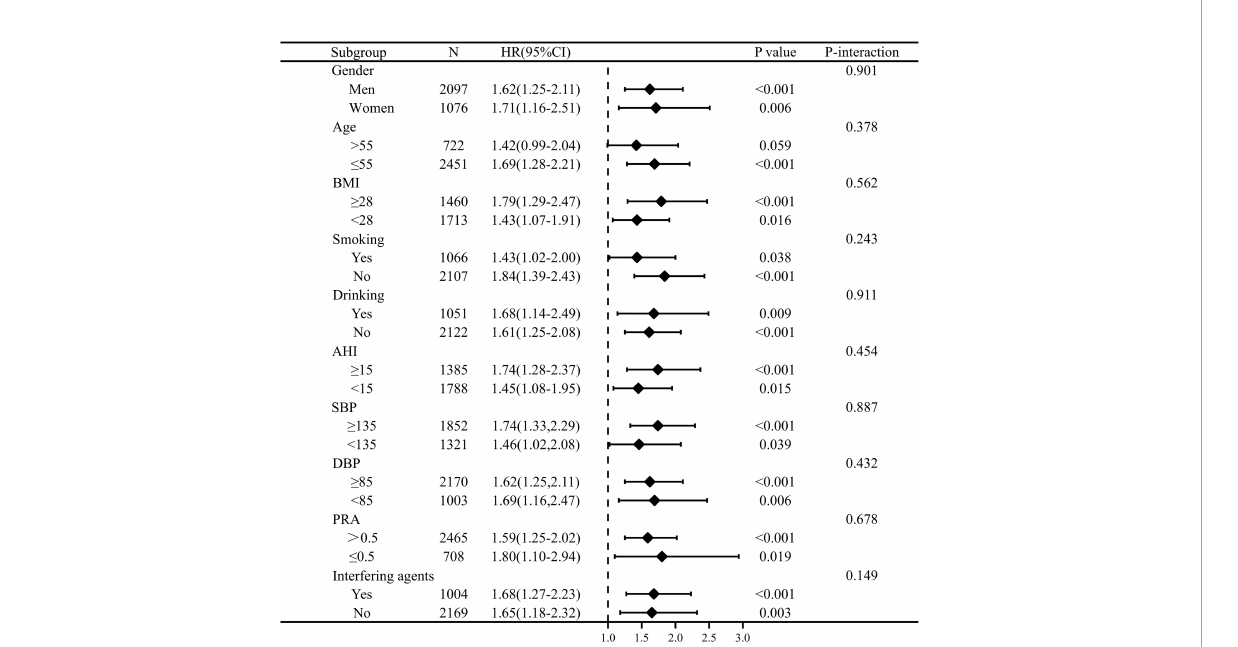
FIGURE 3 Strati fi cation analysis on relationship of PAC with outcome. PAC was converted to binary variables according to the cut-off value of 12.5ng/dl via time-dependent receiver operating characteristic curve. The model was adjusted for gender, age, BMI, DM at baseline, duration of hypertension ≥ 5, cigarette consumption, alcohol intake, AHI ≥ 15, waist circumference, SBP, DBP, eGFR, TC, TG, HDL-C, LDL-C, Lp(a), serum potassium, PRA, and antihypertensive agents, statins, antiplatelet agents, regular CPAP